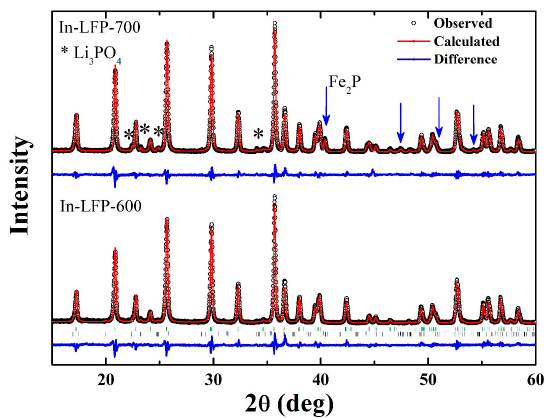
Figure 1. XRD patterns and Rietveld refinement of In-LFP-600 and In-LFP-700 samples. Table 1. Values of LiFePO 4 , Fe 2 P and Li 3 PO 4 estimated from Rietveld analysis of XRD